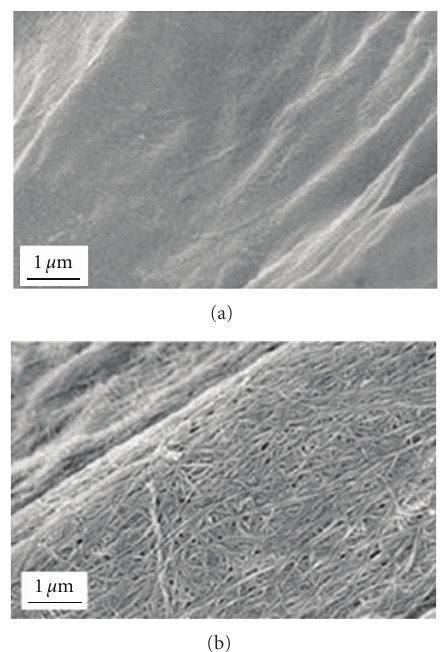
Figure 9: SEM micrographs (a) sisal fiber and (b) bacterial cellu- lose-coated sisal fiber